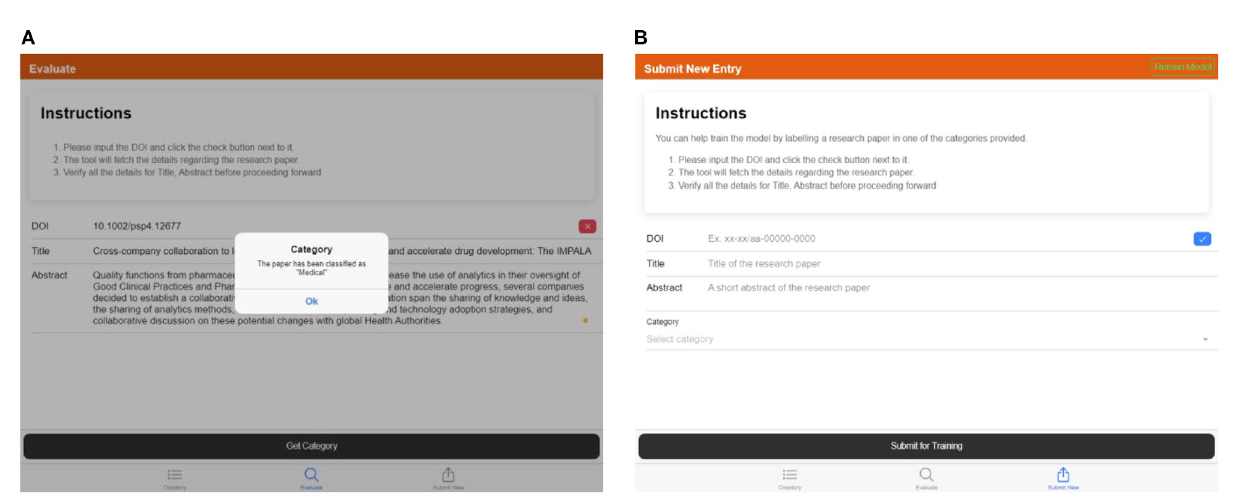
FIGURE11 (A) Screen capture of the “Evaluate” tab—popup showing the category of the provided DOI, (B) screen capture of the “Submit New Entry” tab—details of the article can be provided by manually feeding the DOI, title, abstract, and the relevant category.